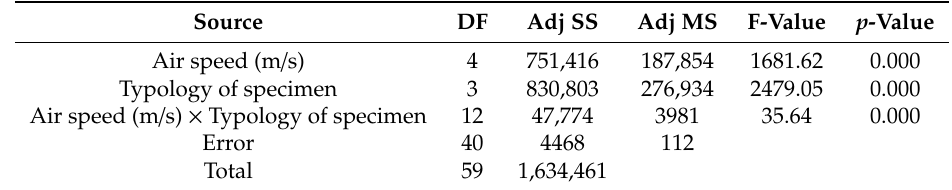
Table 4. Results of ANOVA: p-value, F-value, and R-squared coefficients.